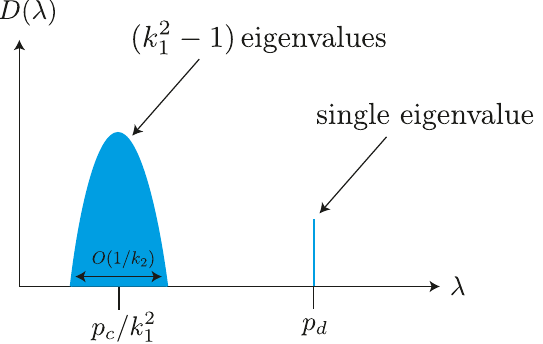
Figure 7 . The spectrum obtained from the resolvent eq. (4.17). We take k 1 < k 2 here so the MP distribution has no zero